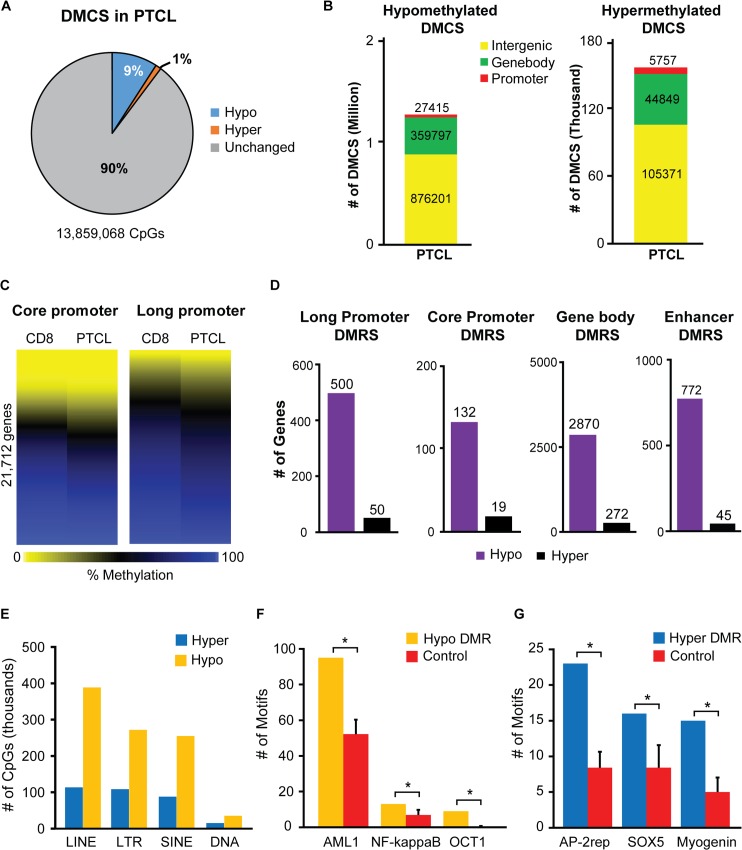
Dnmt3aΔ/Δ PTCL is characterized by genome wide hypomethylation.(A) Percentage of differentially methylated CpGs (DMCS) in Dnmt3aΔ/Δ PTCL relative to wild-type CD8+ cells. Differentially methylated CpGs (DMCS) are defined as either hypo- (blue) or hypermethylated (orange) by a ≥30% change in percent CpG methylation in tumor samples compared to wild-type control samples. CpGs not meeting these criteria are shown in gray (unchanged). (B) Genomic location of hypomethylated (left) and hypermethylated (right) DMCS in Dnmt3aΔ/Δ PTCL, as compared to wild-type CD8+ cells. DMCS were annotated to long gene promoters (-1500 to +500bp relative to TSS), gene bodies, or intergenic regions. (C) Heat map comparing the methylation status of 21,712 promoters in wild-type CD8+ and Dnmt3aΔ/Δ PTCL samples, as determined by WGBS. The averaged percent CpG methylation at core promoter regions (-300bp to +150bp relative to the TSS, left) and at long promoter regions (-1500bp to +500bp relative to the TSS, right) are displayed. (D) The number of genes with differentially methylated regions (DMRS) in their long promoters, core promoters, gene bodies and predicted enhancers in Dnmt3aΔ/Δ PTCL relative to CD8+ control. (E) The number of hypo- and hypermethylated CpGs present in LINE, LTR, SINE, and DNA repeat elements in Dnmt3aΔ/Δ PTCL, as compared to wild-type CD8+ cells. (F) The number of AML1, NF-κB, and OCT1 transcription factor motifs present in hypomethylated promoters in Dnmt3aΔ/Δ PTCL, as compared to wild-type CD8+ cells (yellow). The average motif count of 12 randomly generated control promoter sets is shown in red, with error bars denoting standard deviation. (*) denotes p<0.05 by a Wilcoxon rank test. (G) The number of AP-2rep, SOX5, and myogenin transcription factor motifs present in hypermethylated promoters in Dnmt3aΔ/Δ PTCL, as compared to wild-type CD8+ cells (blue). The average motif count of 12 randomly generated control promoter sets is shown in red, with error bars denoting standard deviation. (*) denotes p<0.05 by a Wilcoxon rank test.